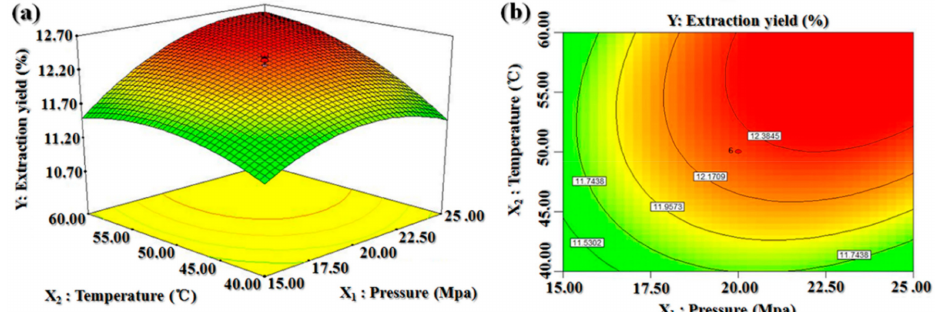
Figure 2. Response surface ( a ) and contour plots ( b ) for the e ff ect of pressure and temperature on the B. dasystachya seed oil